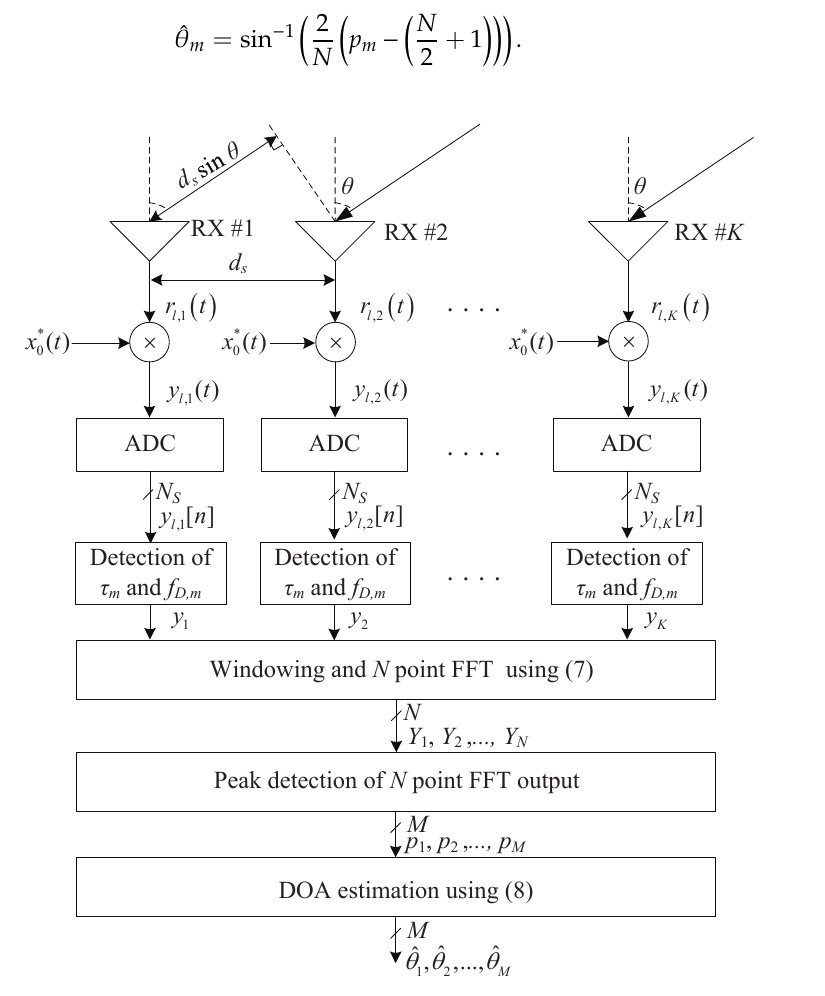
Figure 2. Structure of direction of arrival (DOA) estimation in FMCW